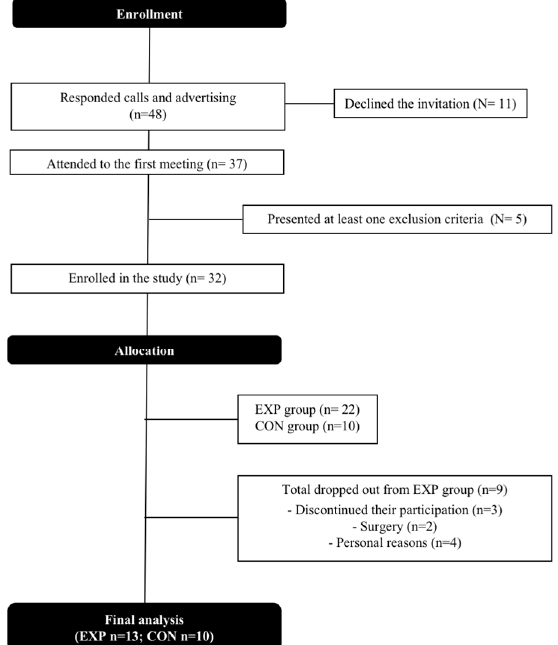
Figure 1. Flowchart of the study. EXP: experimental group; CON: control group.